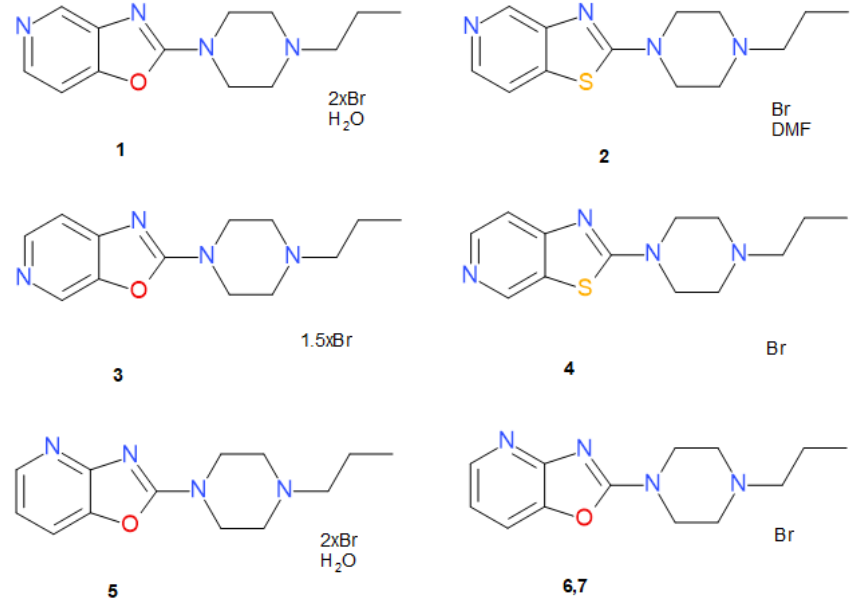
Figure 1. Structural formulas of studied compounds.